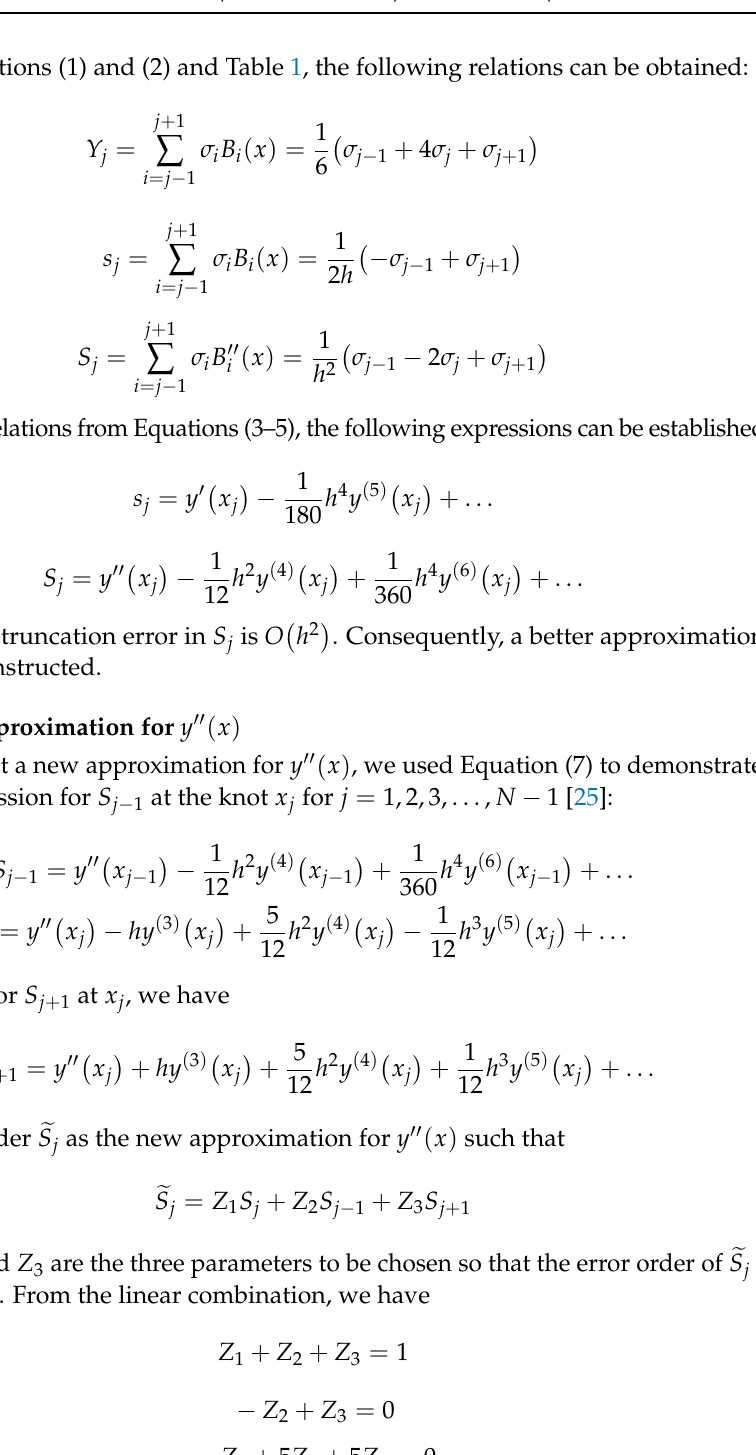
Table 1. Coefficients of B i ( x ) , B (cid:48)